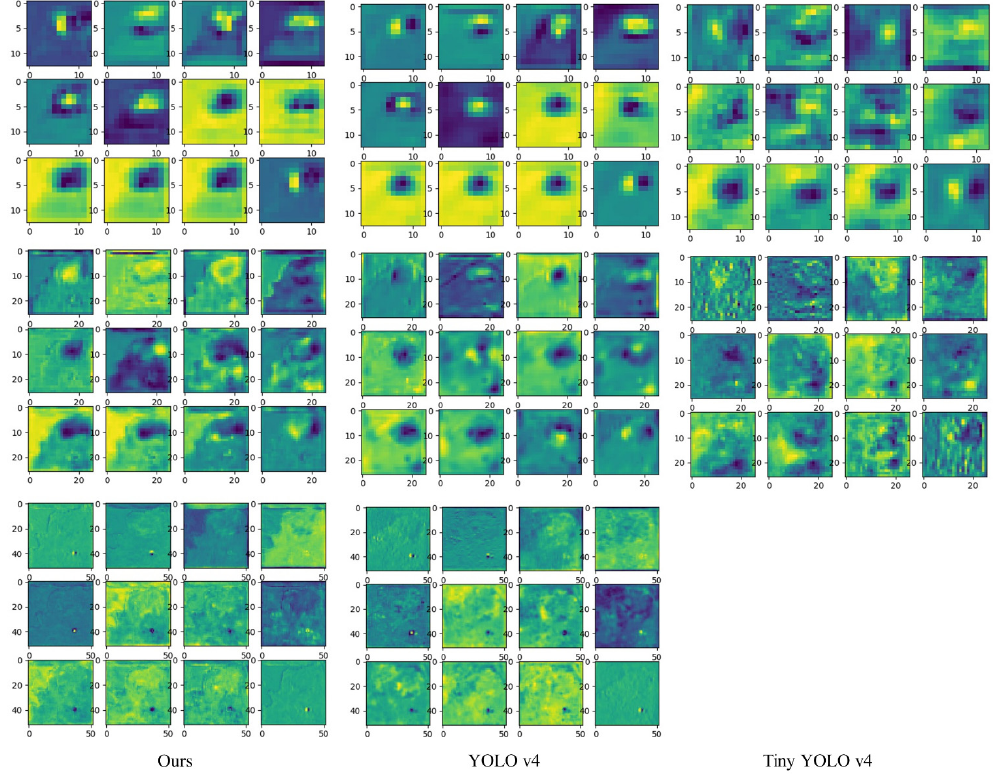
Figure 14. The feature maps of the right image in Figure 12 at different scales. Row 1: feature map of 13 × 13. Row 2: feature map of 26 × 26. Row 3: feature map of 52 × 52.